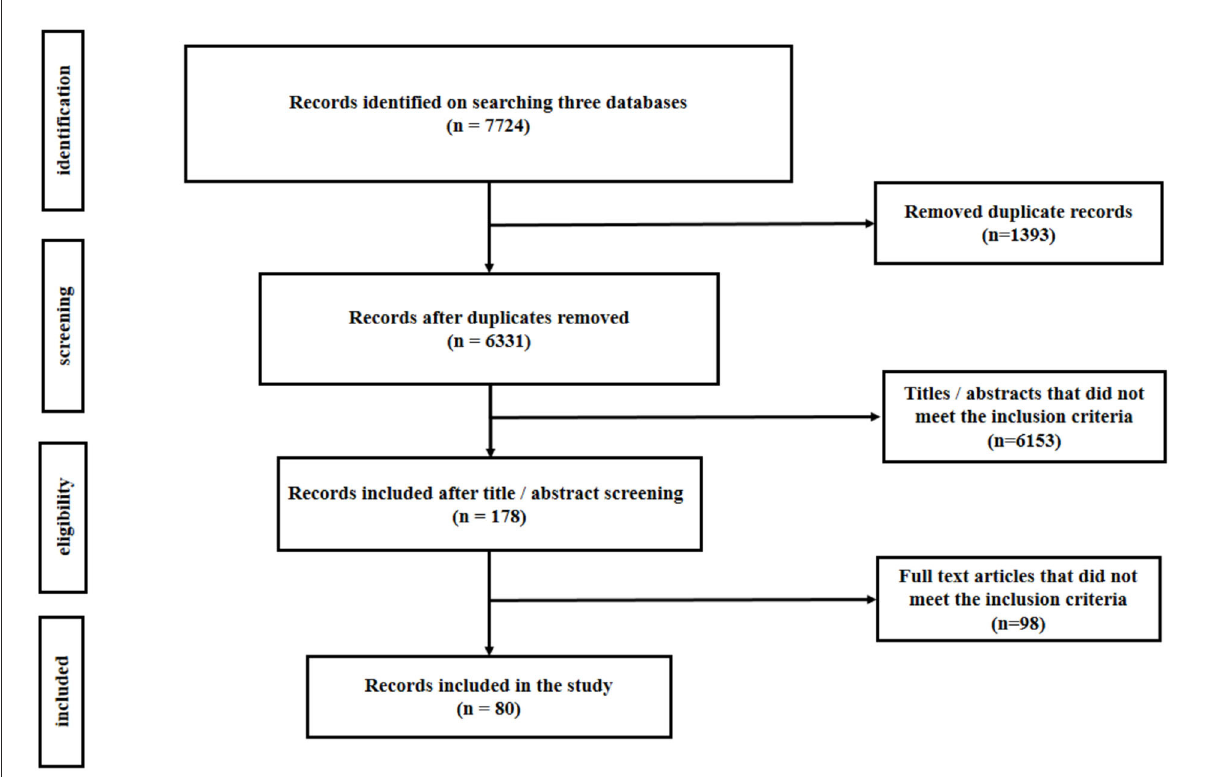
FIGURE1 Flowchart showing the number of records retrieved at different stages of literature